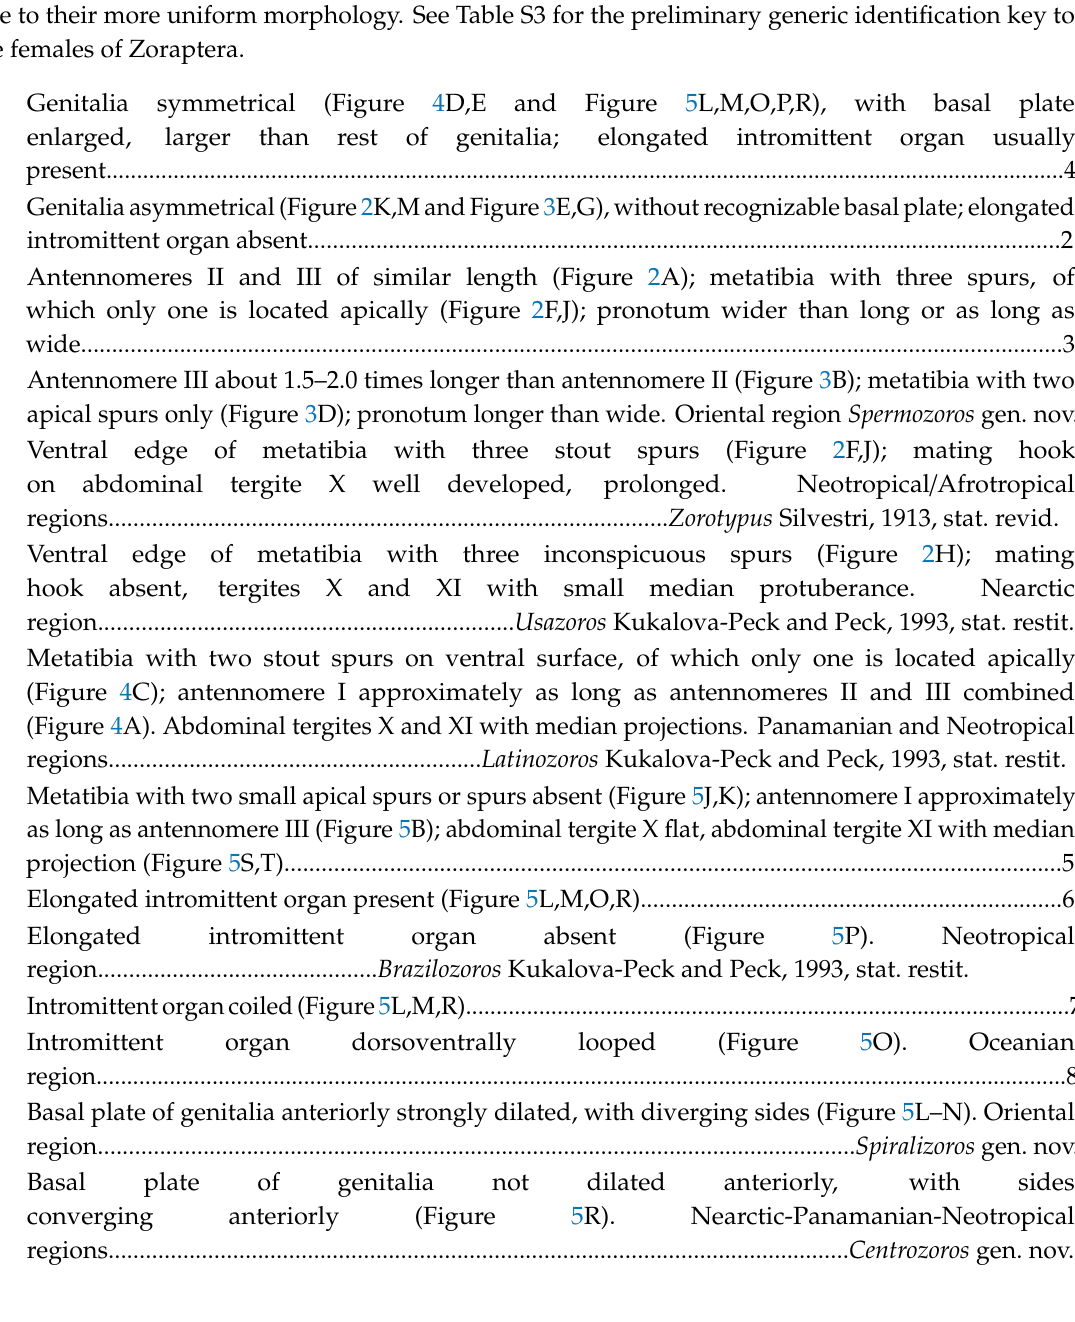
(Figure 5O). Oceanian Basal plate of genitalia anteriorly strongly dilated, with diverging sides (Figure 5L–N).